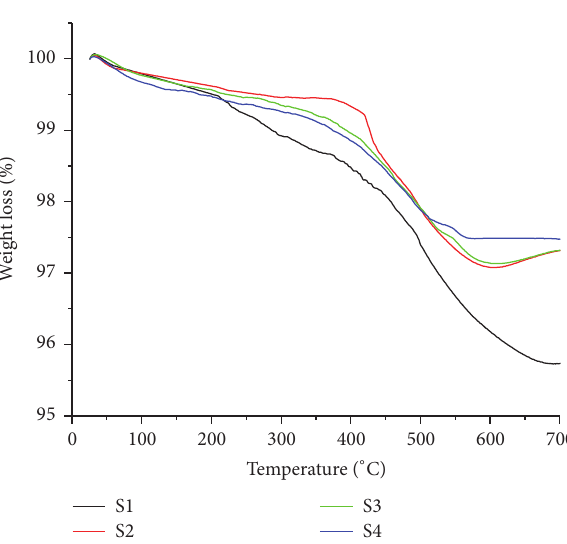
Figure 8: TGA curves of S1–S4 compounds in air.